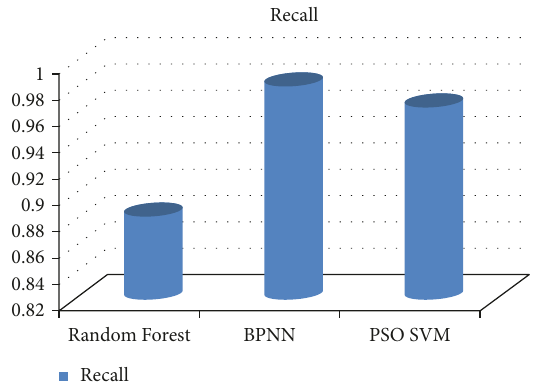
Figure 4: Sensitivity of classifiers for grape leaf disease classification.